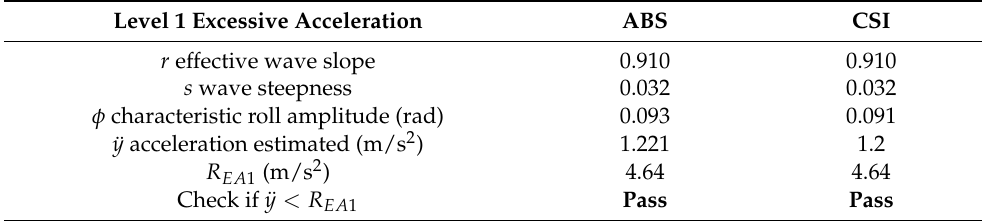
Table 7. Level 1 assessment of excessive acceleration failure mode for barge.